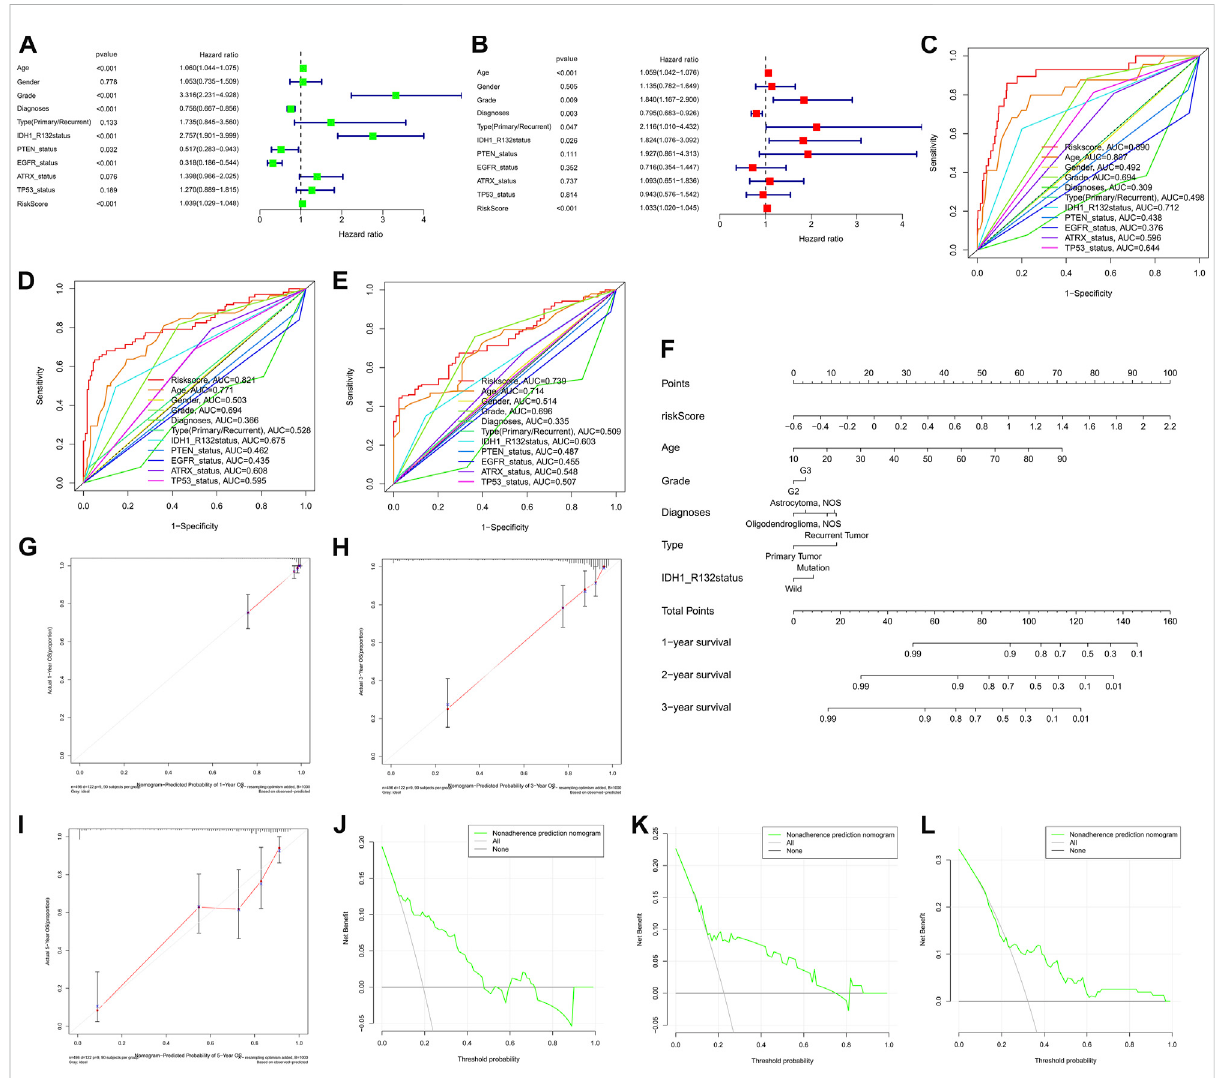
FIGURE 8 (A) nomogrambasedontheASsignatureandclinicalcharacteristicsassociatedwiththem6Amethylationregulator.Coxregressionevaluations onunivariate (A) andmultivariate (B) data,aswellas themodel, indicating excellent prognostic performanceindependent ofclinicalvariables. (C – E) . ROC curve for anticipating overall survival (OS) at 1, 3, and 5 years used to validate the model ’ s prognostic accuracy in contrast with other individual components. (F) A nomogram created using the risk score, grade, diagnoses, age, and type data, as well as the IDH1 ( R132 ) status. (G – I) . Calibration plots showing agreement in anticipating the OS at 1,2, and 3years. (J – L) . The DCA curve demonstrating agreement in anticipating OS at 1, 2, and 3